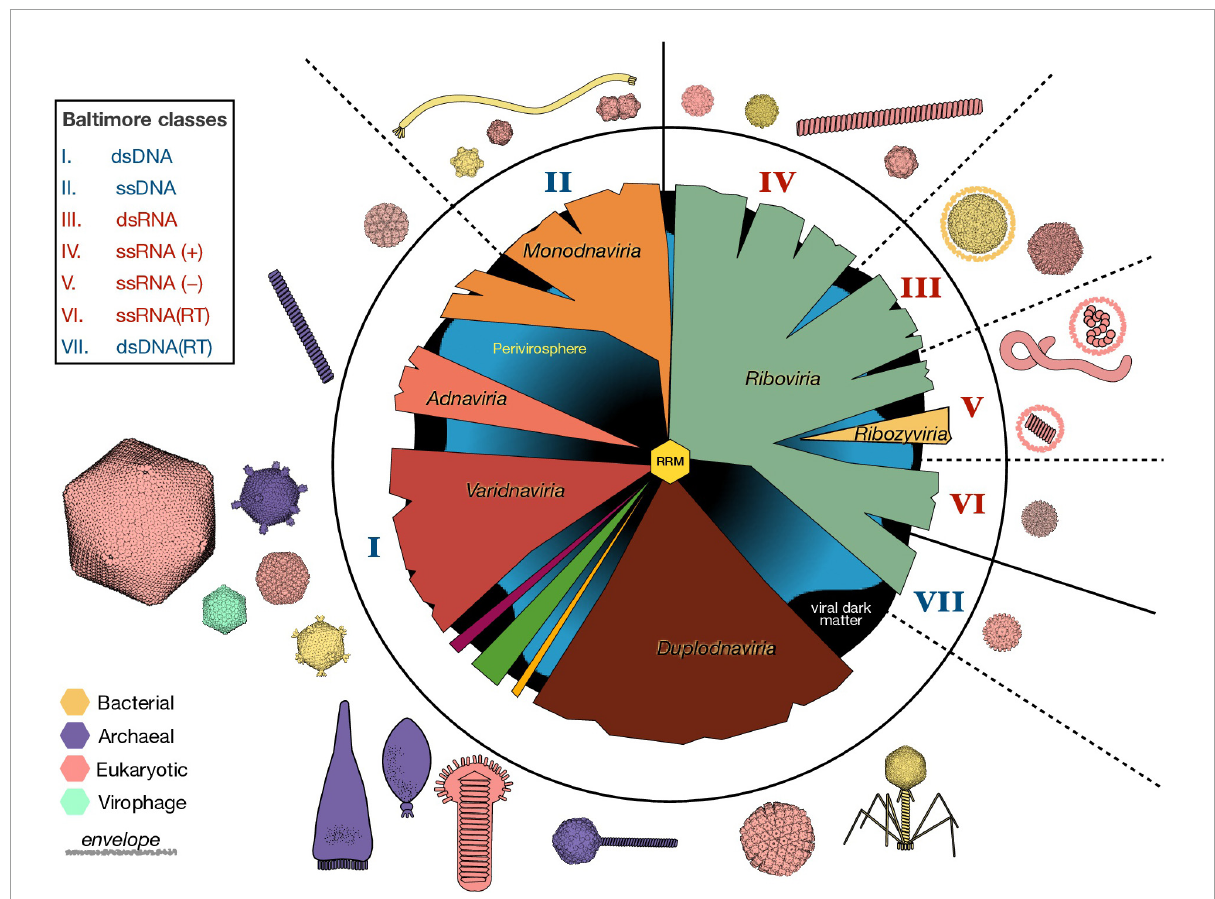
FIGURE2 Organization and Diversity of the Virosphere. The vast genetic diversification of viruses is reflected in a variety of viral genome lengths (1.8 Kb–2.5 Mb) and organizations (e.g., circular vs. linear, segmented or not), virion sizes (17 nm–1 µ m) and morphologies, host ranges, and in the types of interactions between viruses and their hosts. Here, we represent the six virus realms in the middle circle, as they emerge from an ancestral RNA-recognition motif (RRM) in the center. The roman numbers indicate the nature of the packaged nucleic acid according to the Baltimore classification scheme, where blue numbers represent DNA and red numbers RNA. Non-viral mobile genetic elements (perivirosphere) and the unknown viral sequences (viral dark matter) are included in the background. Some representative virus morphologies from viruses infecting all three domains are depicted with approximate relative sizes and colored according to their host. The available molecular structures were downloaded from RCSB Protein Data Bank and visualized with UCSF ChimeraX. ss, single-stranded; ds, double-stranded; RT,